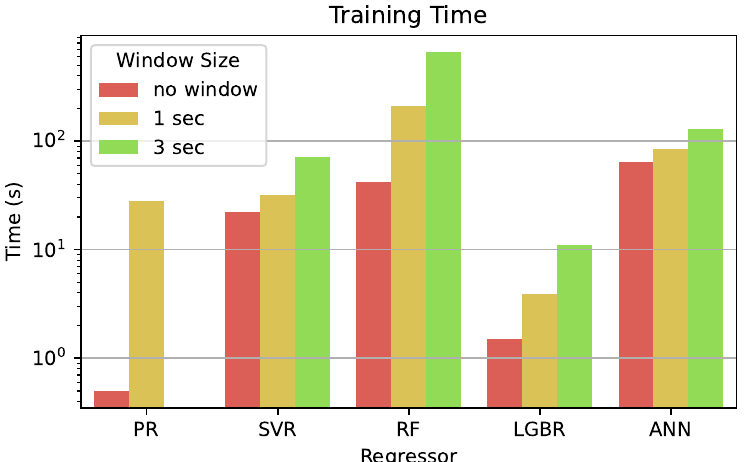
Figure 14. Comparison of the training time of different data-driven models depending on Sliding Window